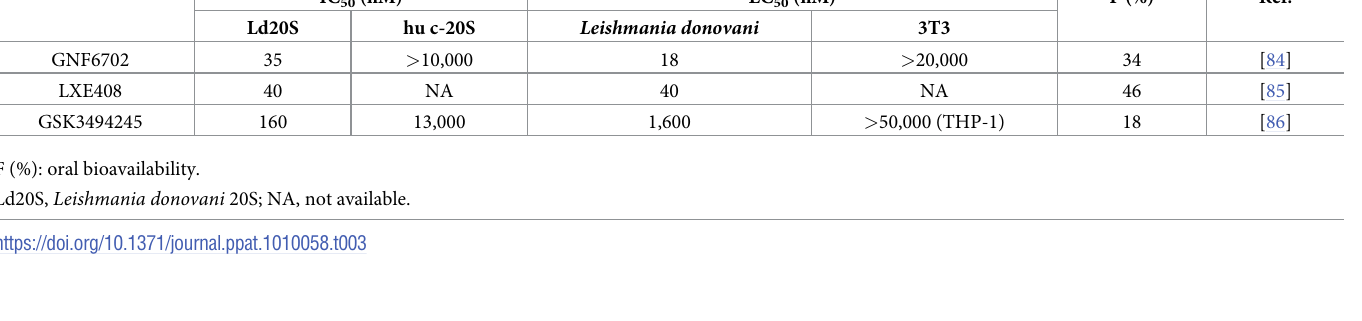
Table 3. Inhibitory activity and antiparasite activity of kinetoplastid proteasome inhibitors. IC 50 (nM) EC 50 (nM) F (%)